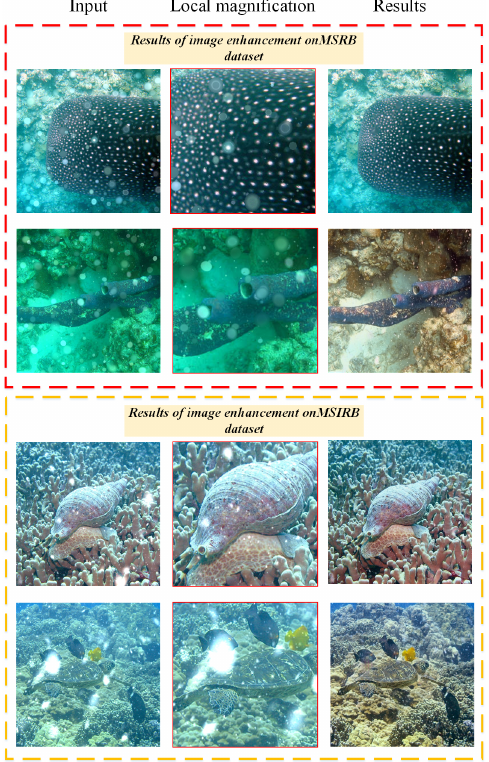
Figure 1. Results of UIR-Net on MSRB and MSIRB